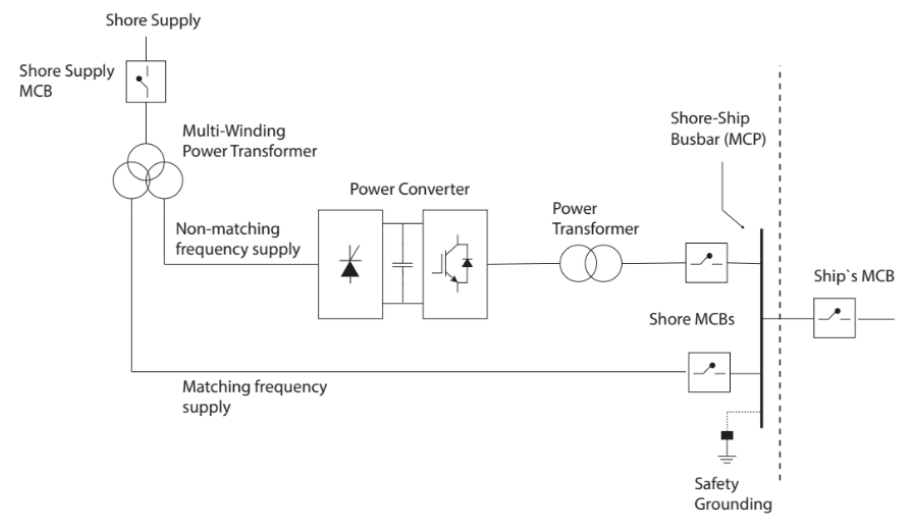
Figure 24. Layout of a typical Cold Ironing on-shore substation. Reprinted from ref. [115].